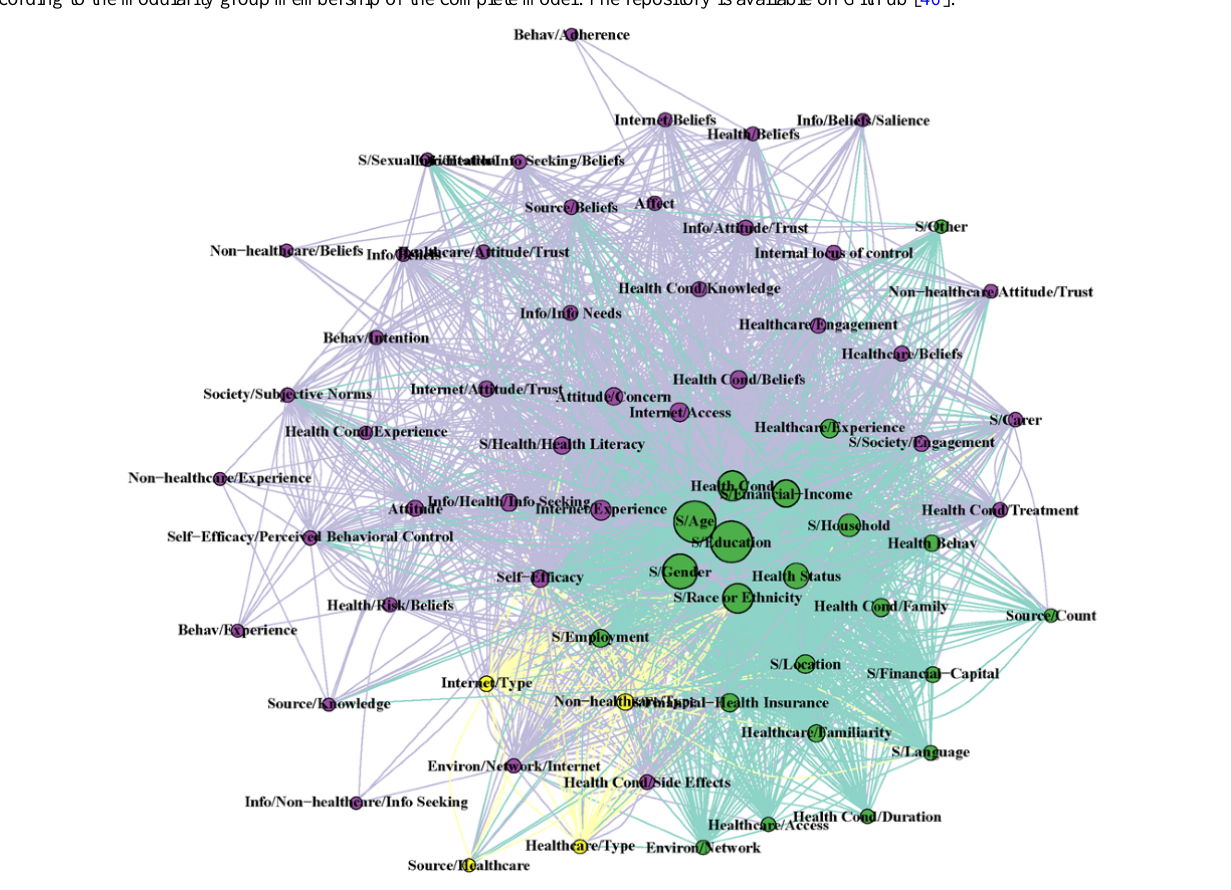
Figure 5. Fruchterman-Reingold layout algorithm of the network analysis comparing the complete model with all years until 2019 with color